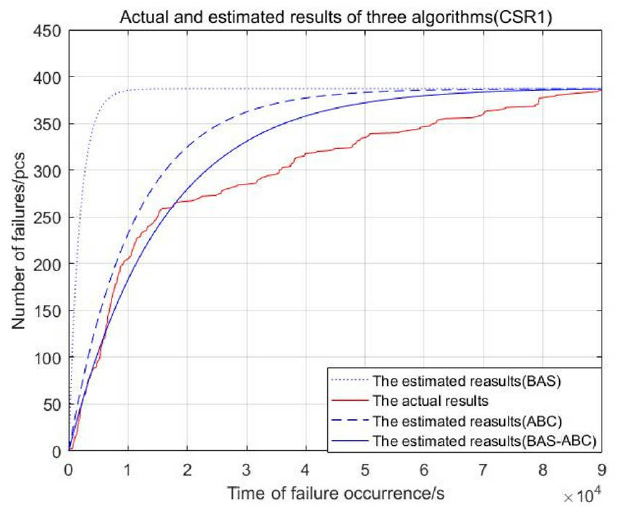
Figure 5. Actual and estimated time of failure occurrence of three algorithms (CSR1).